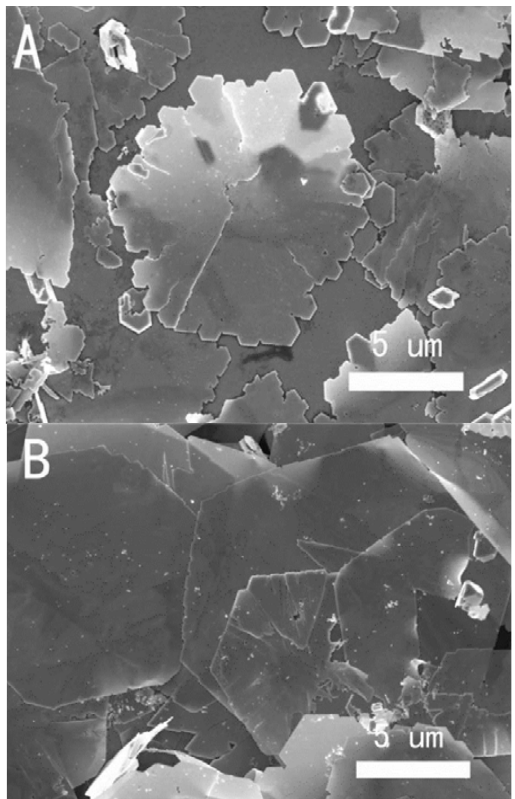
Fig. 14 Fig. 13: Typical SEM images of the Ag nanosheets using 10 µL O . Reproduced with permission 2 2